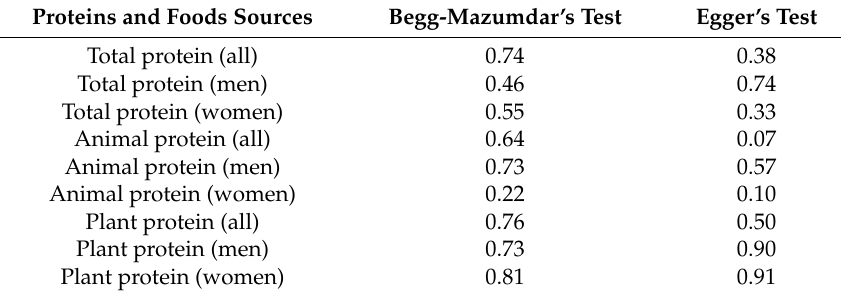
Table 1. Public bias and meta-analysis.